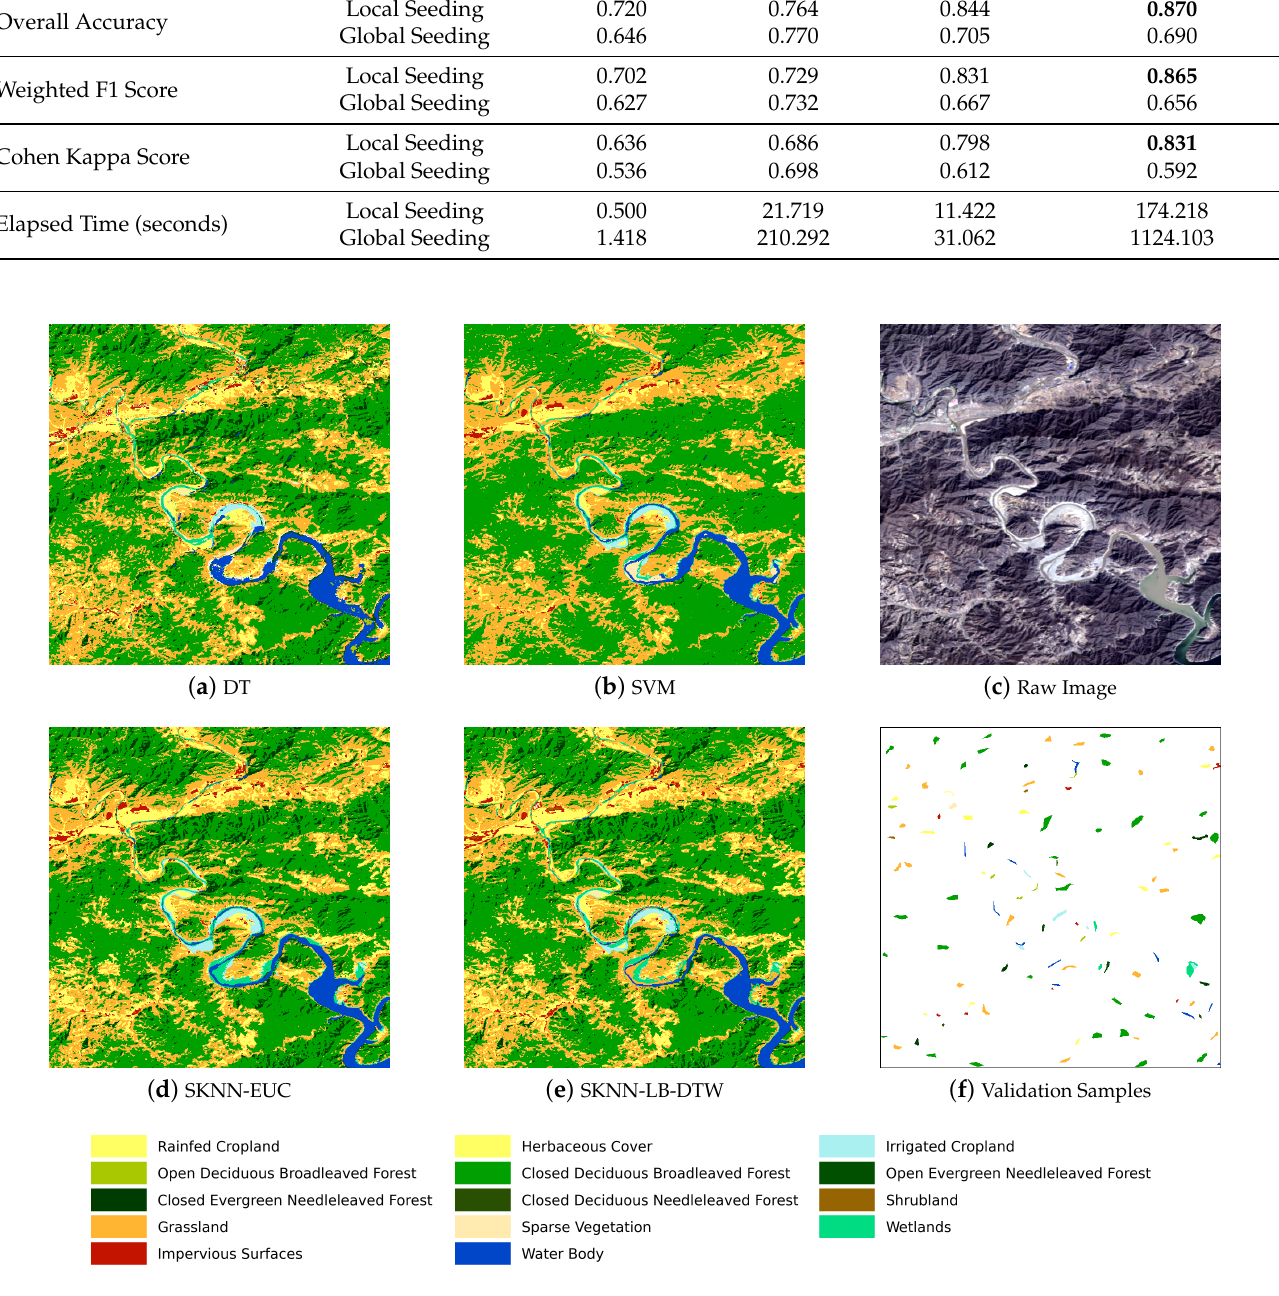
Figure 10. Comparison of classification maps of the second grid with the corresponding validation samples and a reference